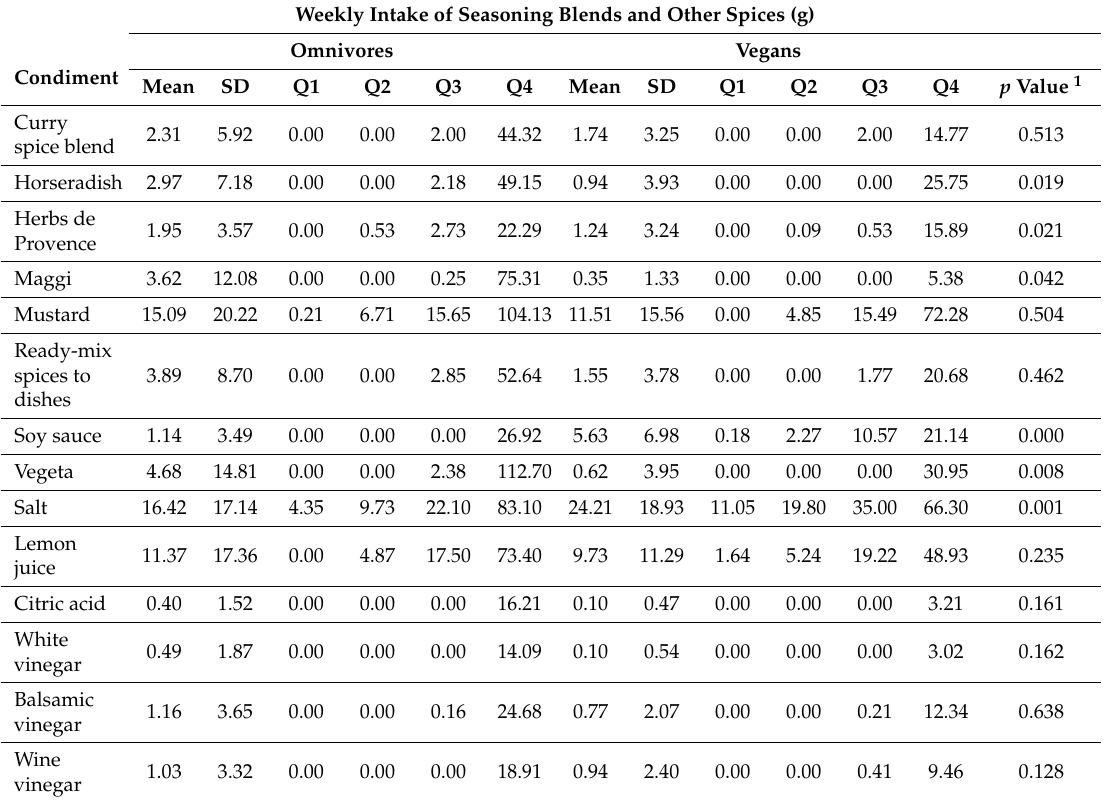
Table 7. Weekly intake of seasoning blends and other spices among adult omnivores and